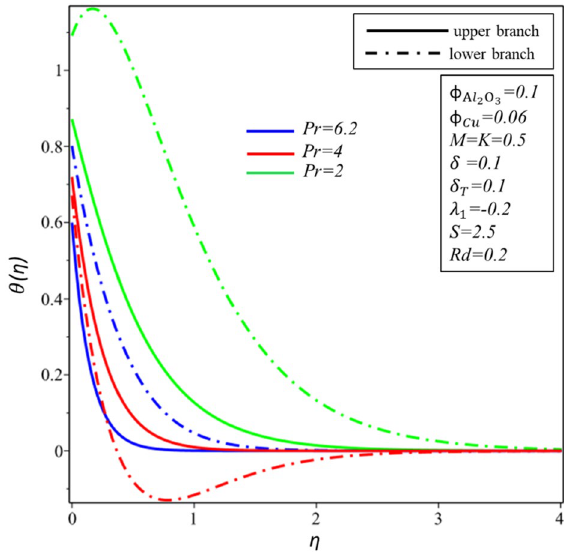
Figure 15. Behavior of θ(η) in impact of Pr .